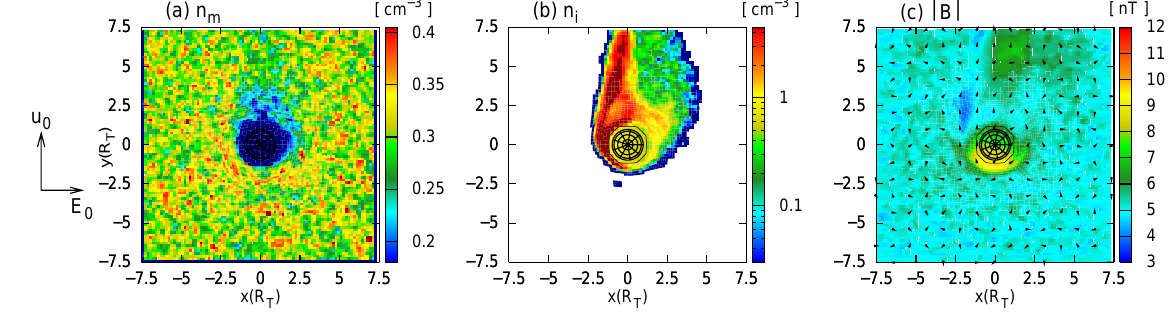
Fig. 13. Titan’s interaction with the sub-alfv´enic, subsonic and submagnetosonic plasma flow in Saturn’s magnetotail region – Cut through the equatorial plane. The figure displays (a) the magnetospheric plasma density, (b) the ionospheric plasma density, and (c) the magnetic field. Mach numbers of the upstream plasma flow: M A =0.77 (alfv´enic), M S =0.27 (sonic) and M MS =0.22